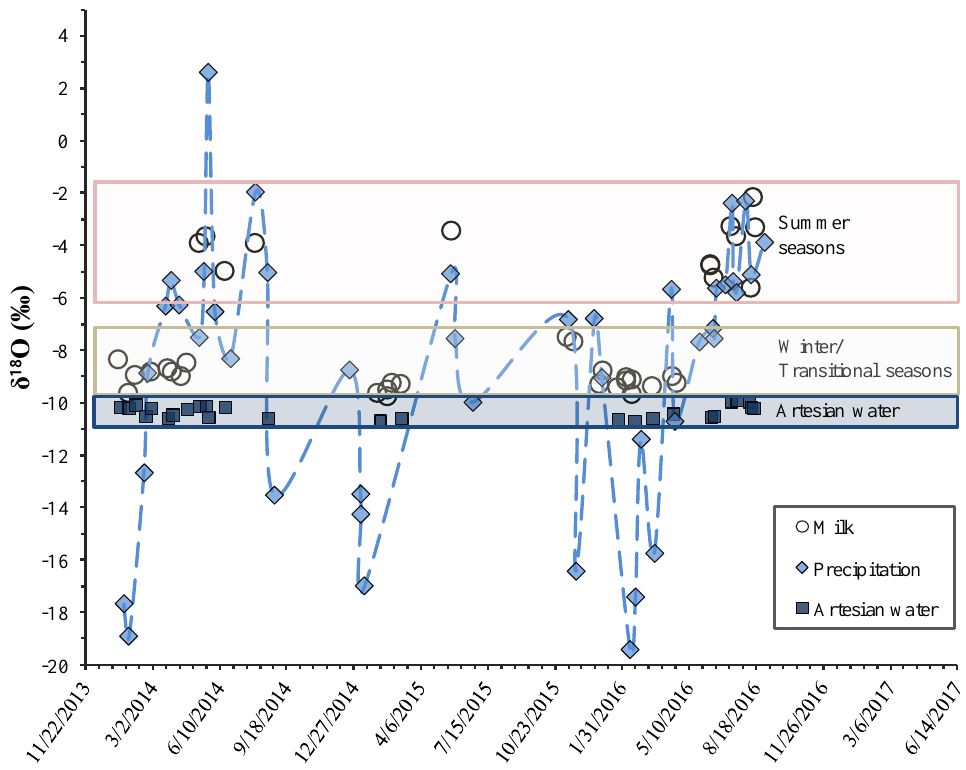
Figure 2. Seasonal variation in δ 18 O values in milk water, artesian water, and precipitation water in the rural site in Lithuania during 2014–2016. Dashed blue line integrates measured δ 18 O values of precipitation. Boxes indicate which δ 18 O values of the cow milk fall into the range of summer or winter/transitional seasons.